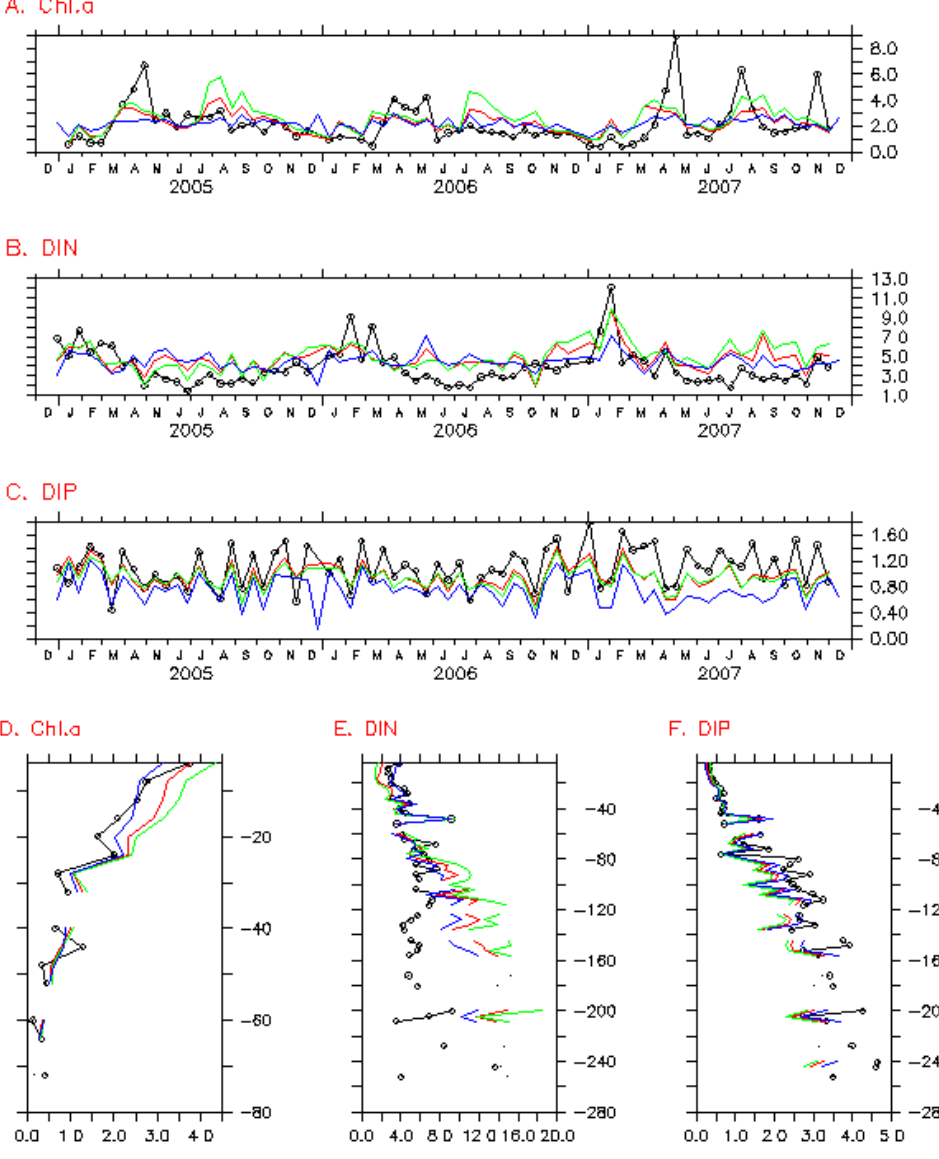
Fig. 3. Comprehensive comparison of model results with all available observations for three experiments. Colors same as in Fig. 2.